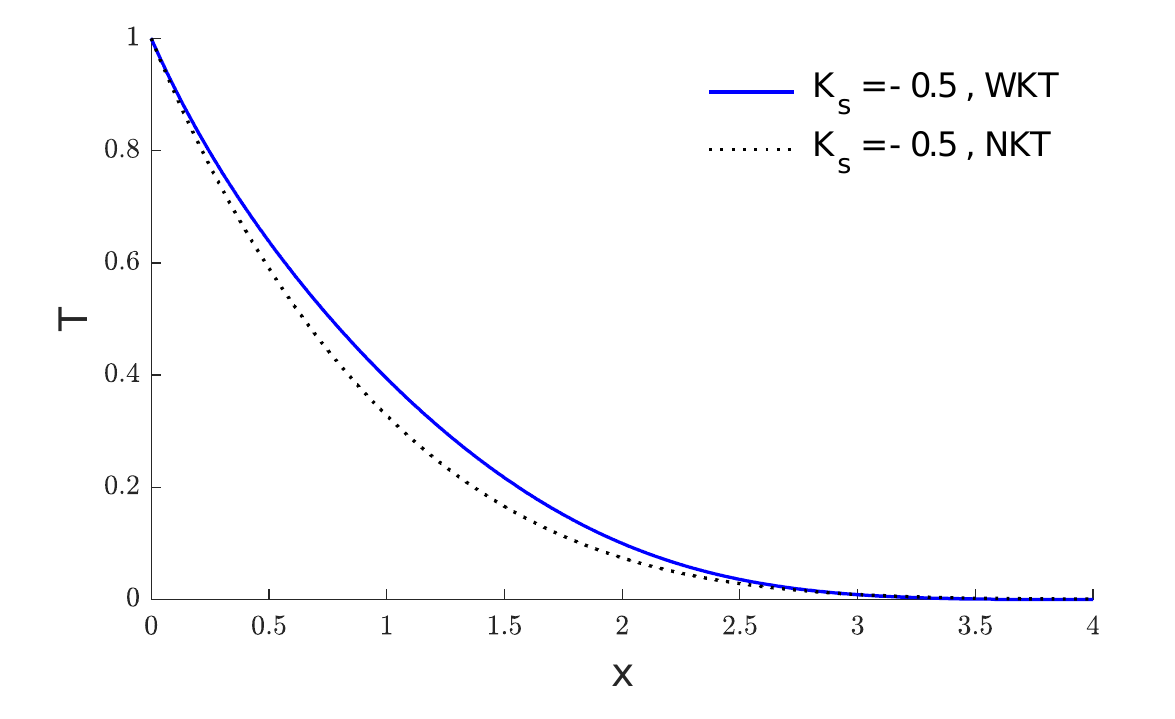
Figure 9. The variations of temperature with and without Kirchhoff transforms when 𝐾 𝑠 = −0.5 .